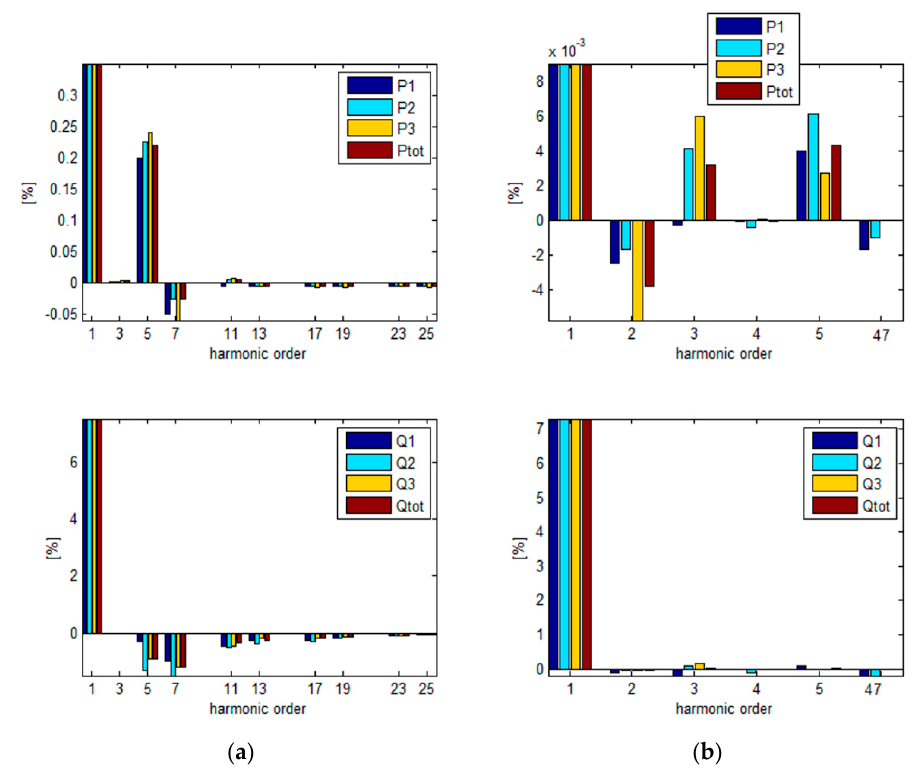
Figure 12. Representative spectral components of the active powers (top) and reactive powers (bottom), absorbed from the supplying source, before ( a ) and after compensation ( b ).